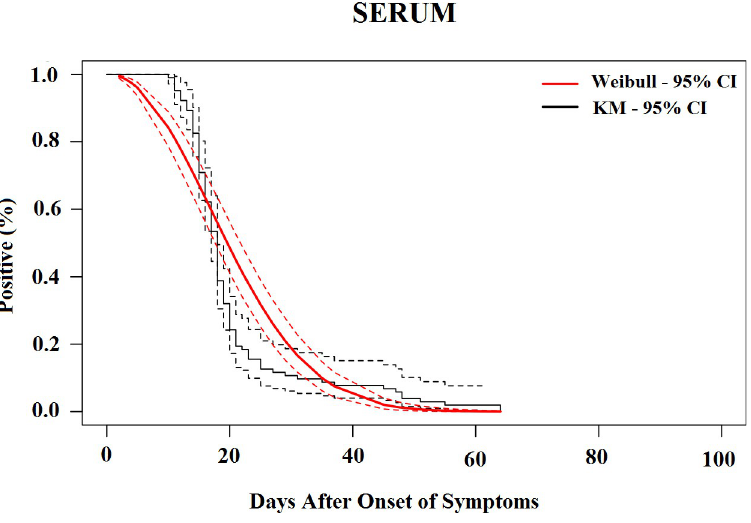
Fig 2. Survival curves (Kaplan–Meier analysis) of CHIKV RNA persistence in Serum, with Weibull fit.